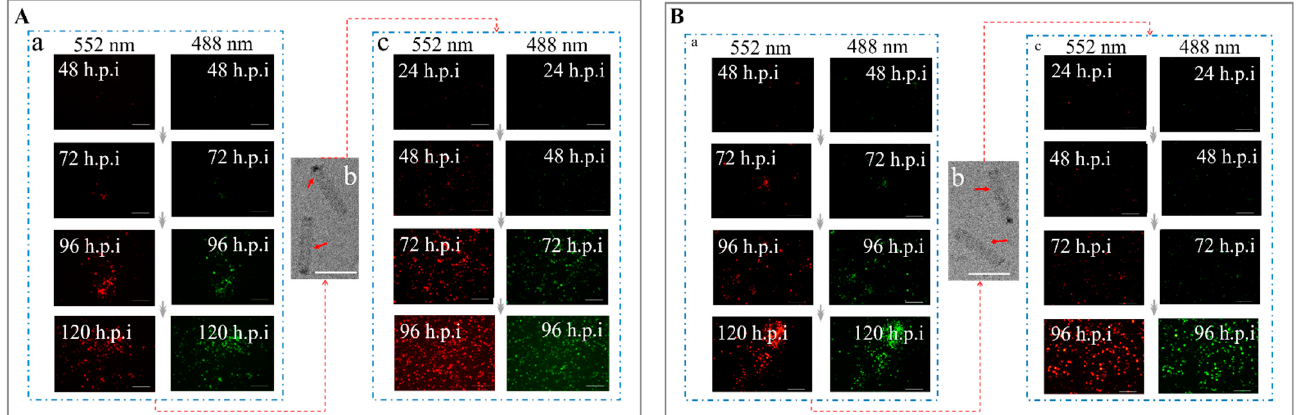
Figure 9. Construction of recombinant baculoviruses AcBV-E64-G64-I64-P64-G-M and AcBV- Δ gp64-E64-G64-I64-P64-GM-Igp64. ( A ) Construction of recombinant